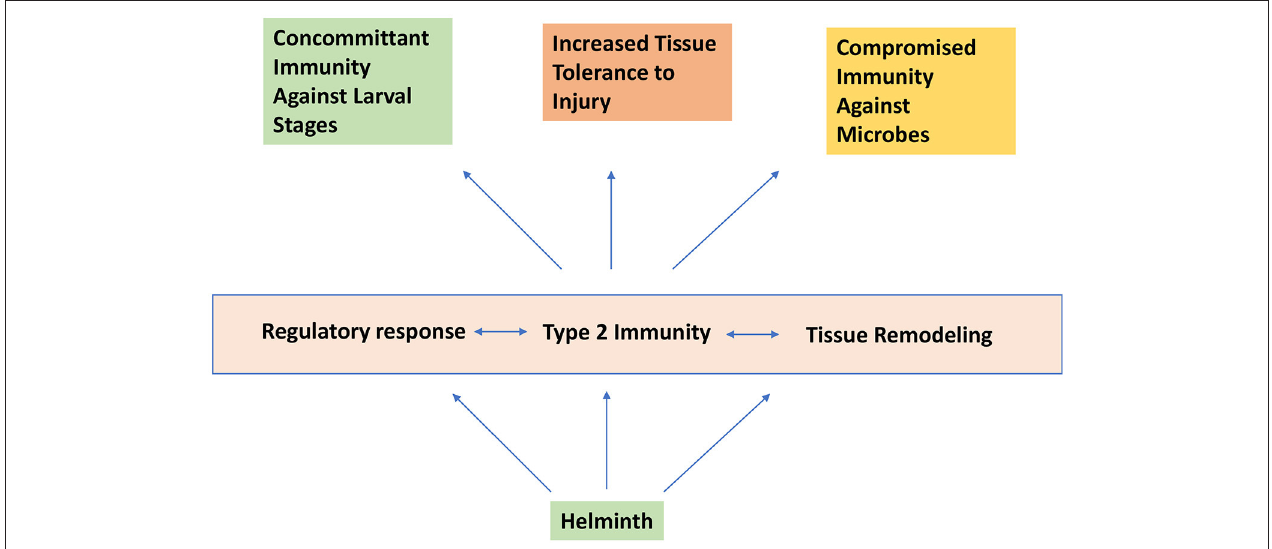
FIGURE 3 | Helminth infection induces concomitant immunity and increased tissue tolerance to injury while promoting compromised immunity to certain microbial agents.